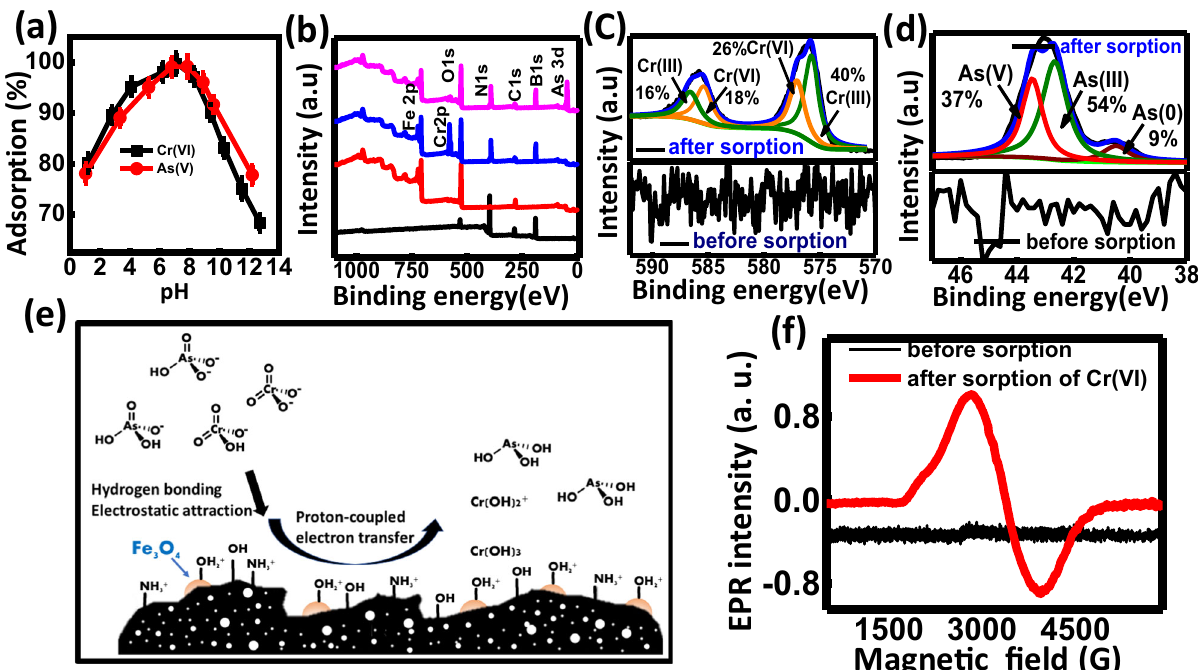
Fig. 5 High valued spectroscopic investigations. Examination of Cr(VI)- and As(V)-adsorbed MHAs. a Effect of solution pH against adsorption of Cr(VI) and As(V) on the adsorbent. b XPS survey spectra of PEI- h -BNNSs-loaded PVA aerogels (black curve), MHAs (red curve), Cr(VI)- adsorbed MHAs (blue curve) and As(V)-adsorbed MHAs (magenta curve). High-resolution XPS spectra of MHAs in the ( c ) Cr2p and ( d ) As3d regions. e Schematic illustration of the proposed mechanism related to the MHA ’ s-mediated reduction of Cr(VI) and As(V). f EPR spectra of MHA ’ s before and after sorption of Cr(VI) for 8